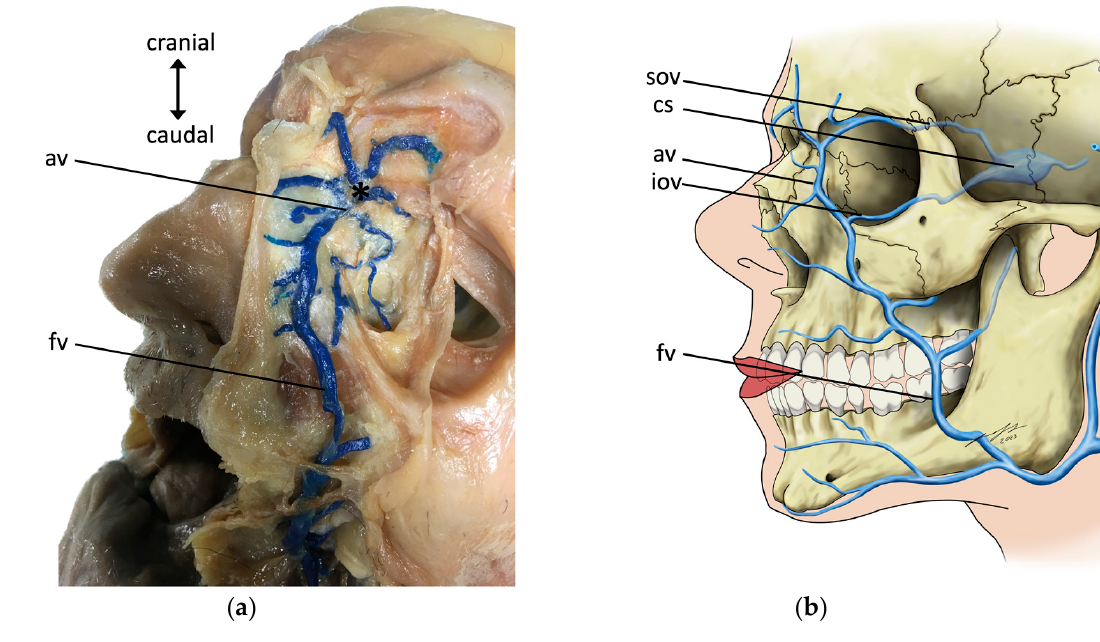
Figure 1. Illustration of the anastomosis (*) of the facial vein (fv) and the superior ophthalmic vein (sov). ( a ) Left side of a male specimen’s face. The facial vein (fv) was injected with blue latex and carefully dissected. Anastomosis via the angular vein (av) was found. ( b ) A schematic overview of